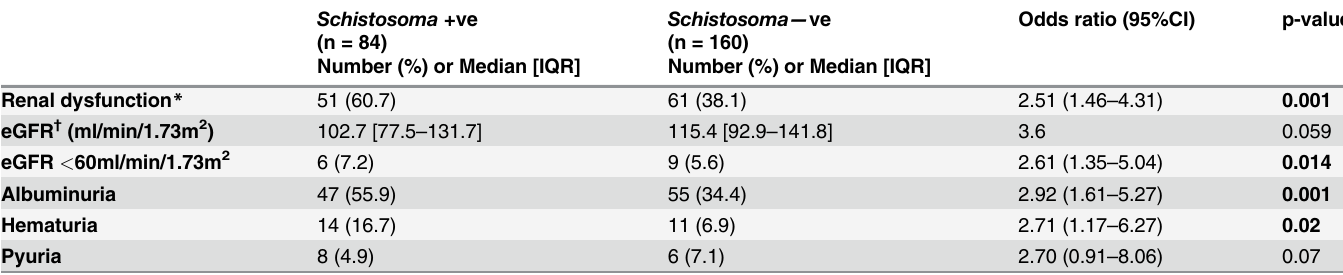
Table 4. Markers of renal dysfunction associated with Schistosoma infection by univariable logistic